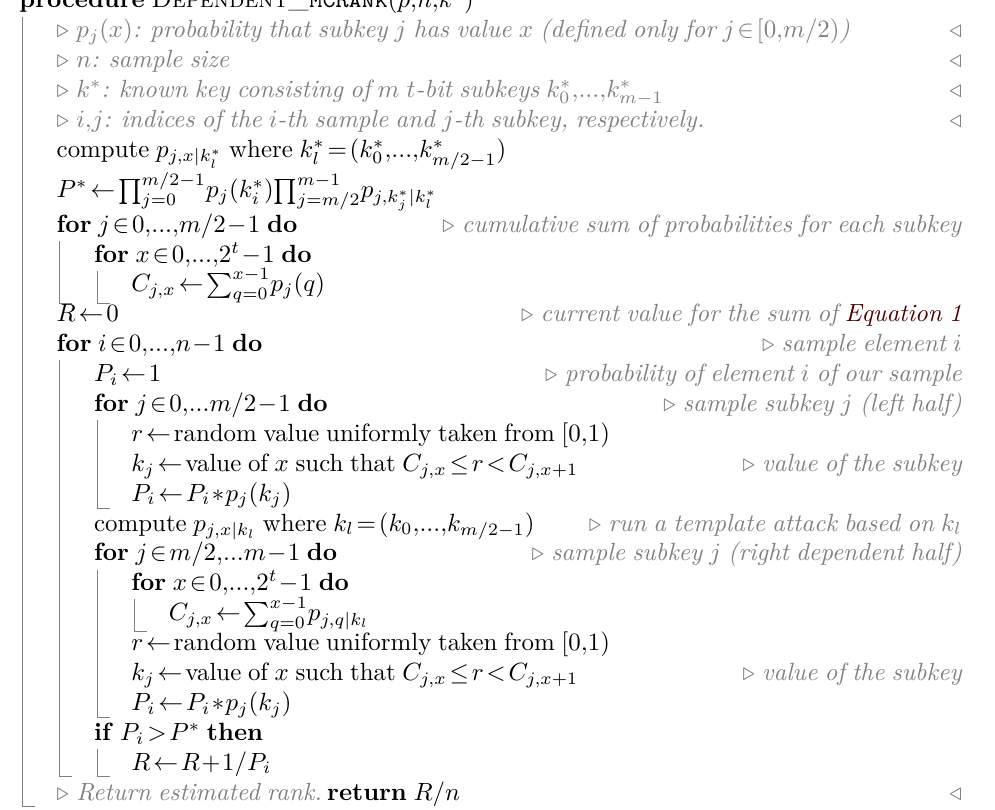
Algorithm 3 Rank estimation with dependent probability distributions procedure Dependent_ MCRank ( p,n,k ∗